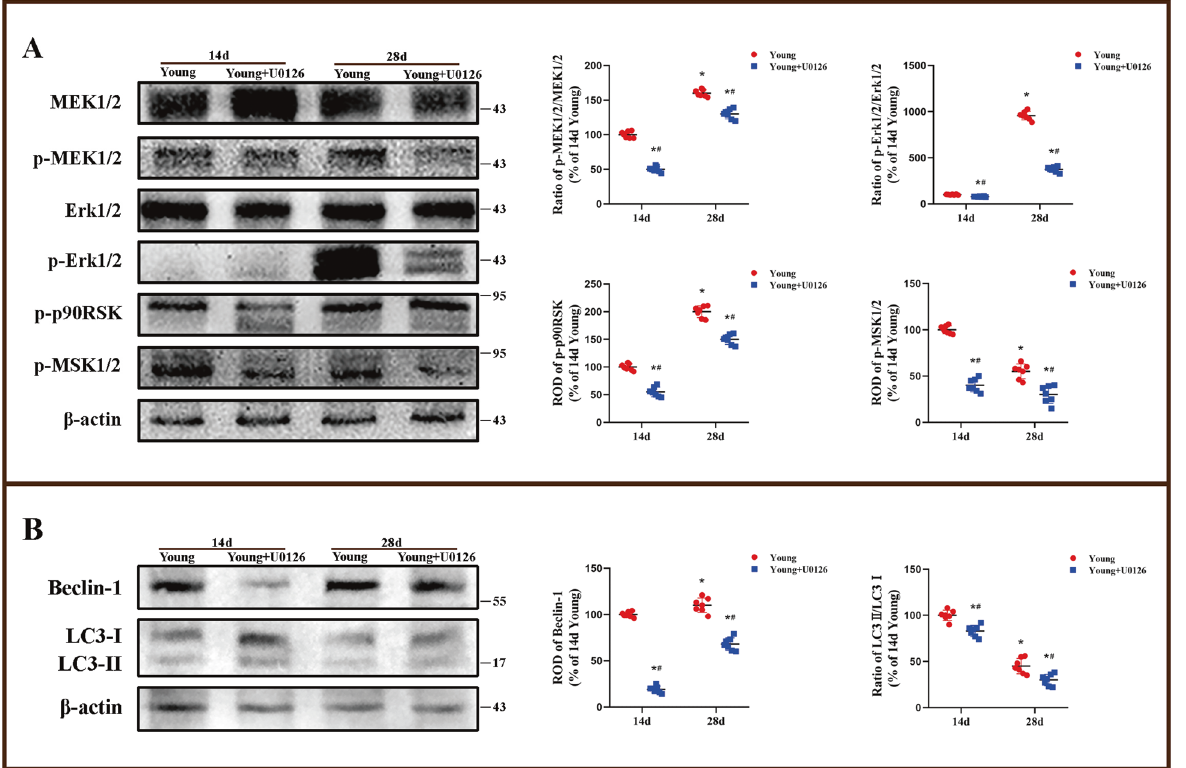
Fig. 6 Change of Erk1/2 signaling and autophagy-related protein levels by U0126 treatment. Western blot analysis of p-MEK1/2, MEK1/2, p-Erk1/2, Erk1/2, p-p90RSK and p-MSK1/2 in the hippocampus of the young gerbils treated with U0126 ( A ). Western blot analysis of Beclin-1, LC3-I and LC3-II in the hippocampus of the young gerbils treated with U0126 ( B ) ( n = 7 per group; * p < 0.05, signi fi cantly different from the 14 days young group, # p < 0.05, signi fi cantly different from the young group at the same reperfusion time). Bars indicate mean ±